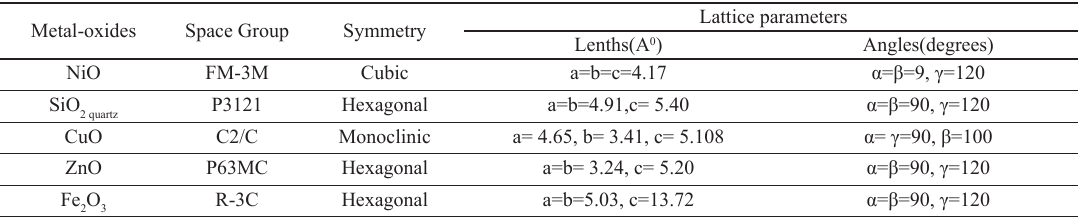
Table 1. Symmetry, space group and lattice parameters of studied metal oxides